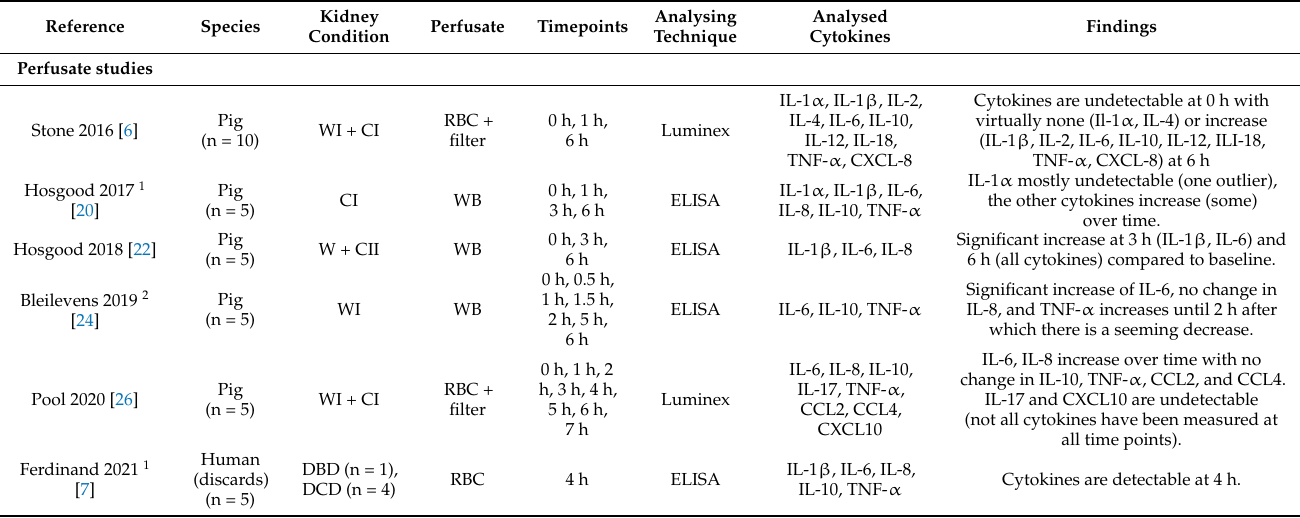
Table 1. Overview of study set-up, sampling times, and cytokines that were investigated, and findings of studies identified by the systematic